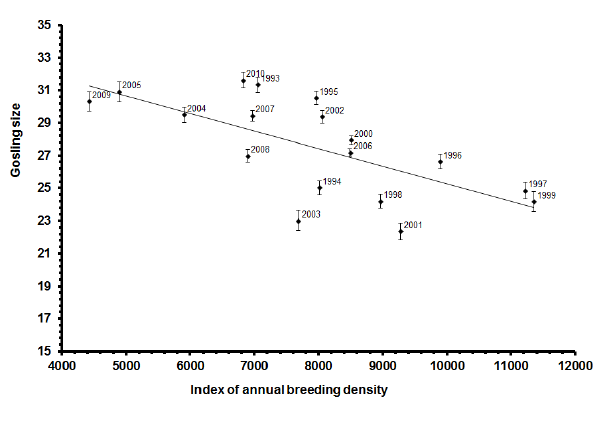
For survival analyses, we used banding data from 26,998